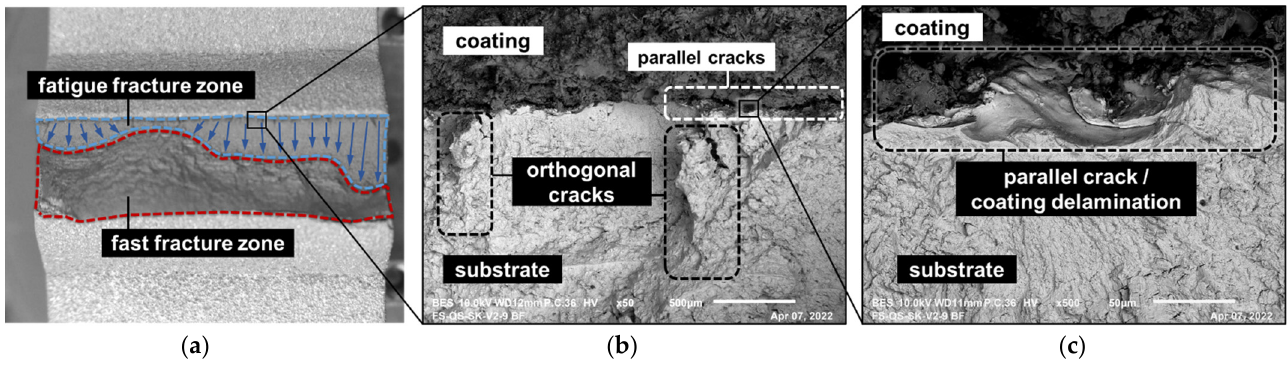
Figure 11. The fracture surface of a grit-blasted specimen with transverse stiffeners. ( a ) Overview image showing the fatigue fracture zone and the fast fracture zone; arrows indicate the origin and direction of fatigue crack propagation. ( b ) The BSE image of the interface area showing different orientations of secondary cracks in the fatigue fracture zone. ( c ) The BSE image of the parallel crack at the interface of the coating.